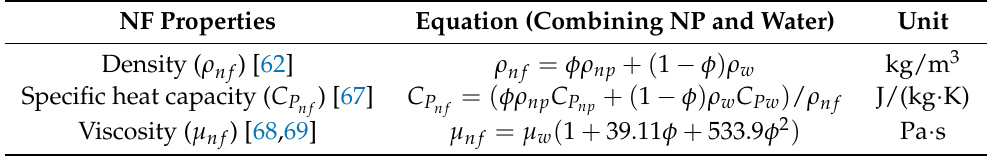
Table 7. NF thermophysical